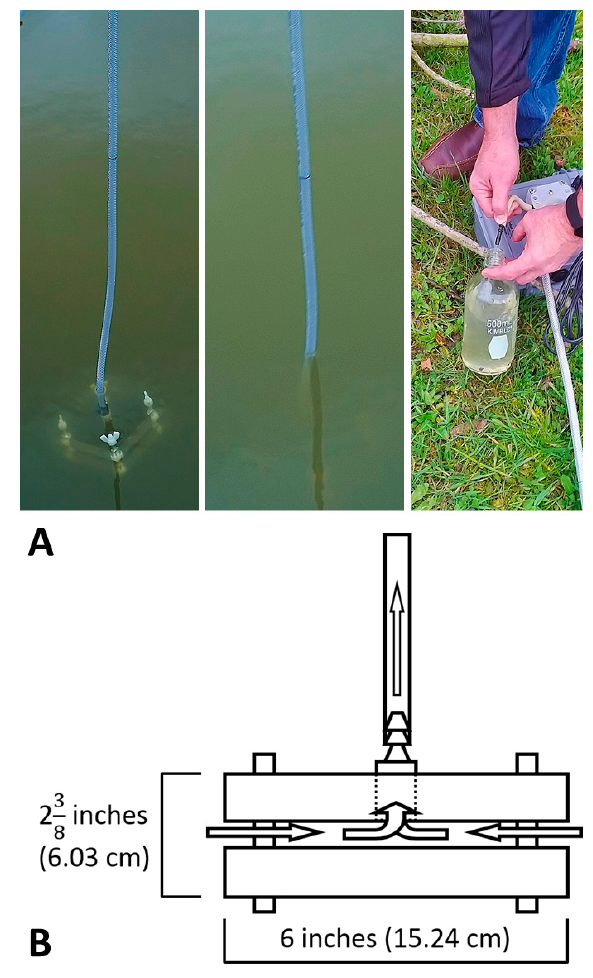
Figure 3. Use and action of the water sampler. ( A ) Lowering the sampler into the water by its tubing and subsequent sample collection in a rinsed and sterilized bottle. ( B ) Schematic diagram showing the mechanism of water sample collection (arrows indicate water flow). A major advantage of this design is that the water sample is pulled between the two acrylic squares within a space of 1 cm, allowing for high-resolution sampling and precise data